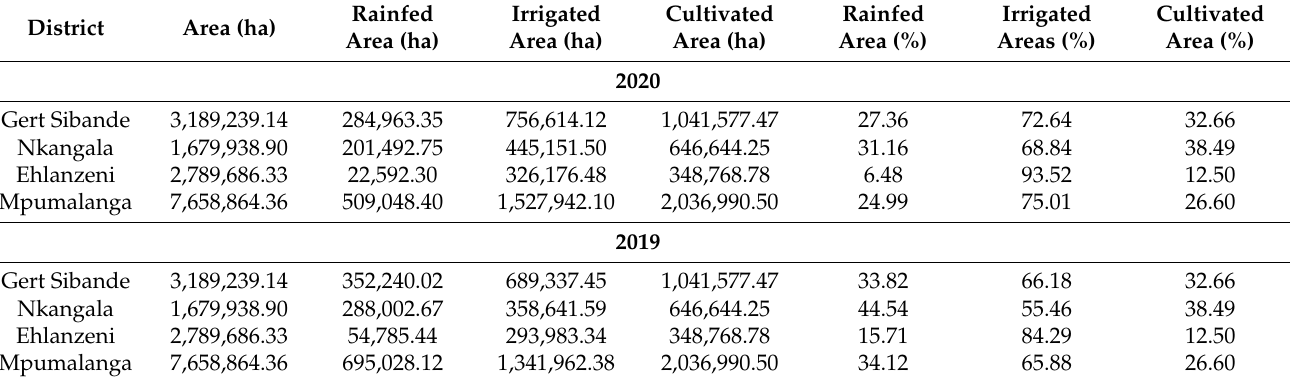
Figure 8. Distribution of cultivated lands in Mpumalanga Province and the proportion between irrigated and rainfed areas per district as well as the changes that took place between 2019 (map a ) and 2020 (map b ). Table 2. Disaggregated proportions of cultivated areas per cultivation type between 2019 and